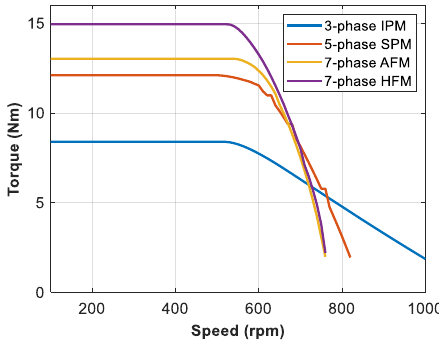
Figure 11. Torque-speed characteristics.